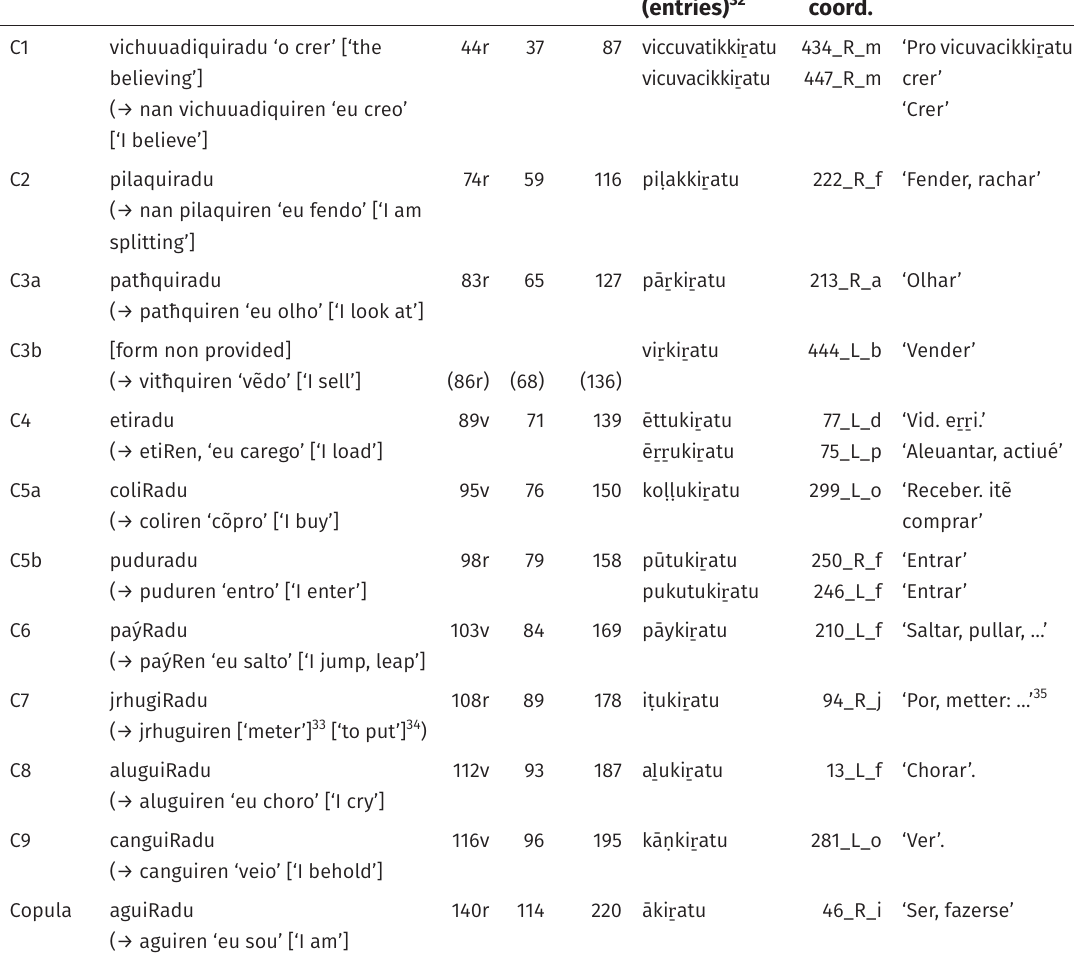
Table 2: occurrences of the items belonging to the α-J type in HH‘s Arte (along with the Present stem forms to which they are attached): the α-J type will be baptized Infinitivus Subſtantivus by Ziegenbalg 150 years later. Conjug. Arte 31 (with English from